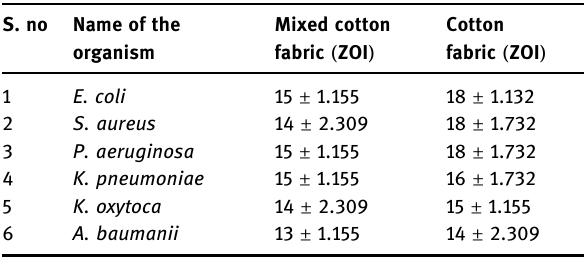
Table 2: Antimicrobial sensitivity test of AS - ZnONPs coated cotton fabrics against the